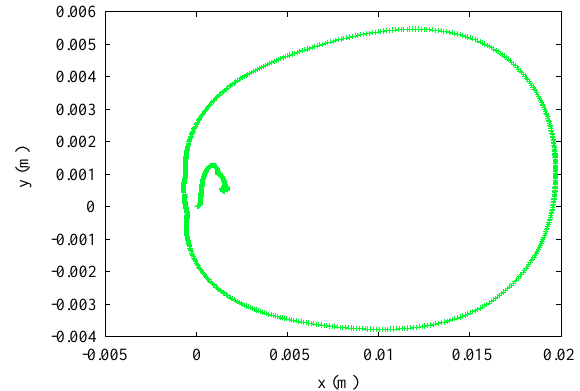
FIG. 16. (Color) Tracking through a bend with coil radii of 0.03 and 0.3 m. The coil geometry was optimized for zero translation with coil radius (cid:114) (cid:173) (cid:48)(cid:46)(cid:51) m, as seen in the large loop. Reducing the coil size alters the fields, with a corresponding change in the particle orbit. This new orbit, which has not been tuned for zero translation, is quite different, with less perpendicular motion. Both tracks start at (0,